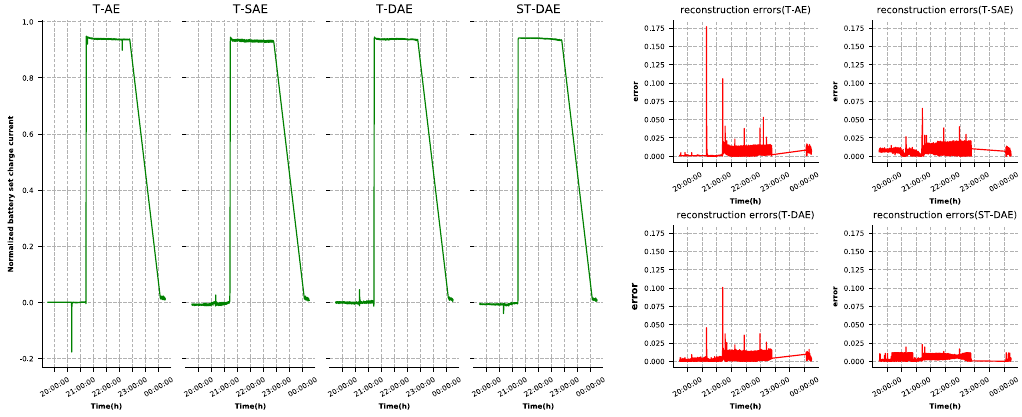
Figure 8. Battery charge regulator (BCR) input current reconstruction results and errors.